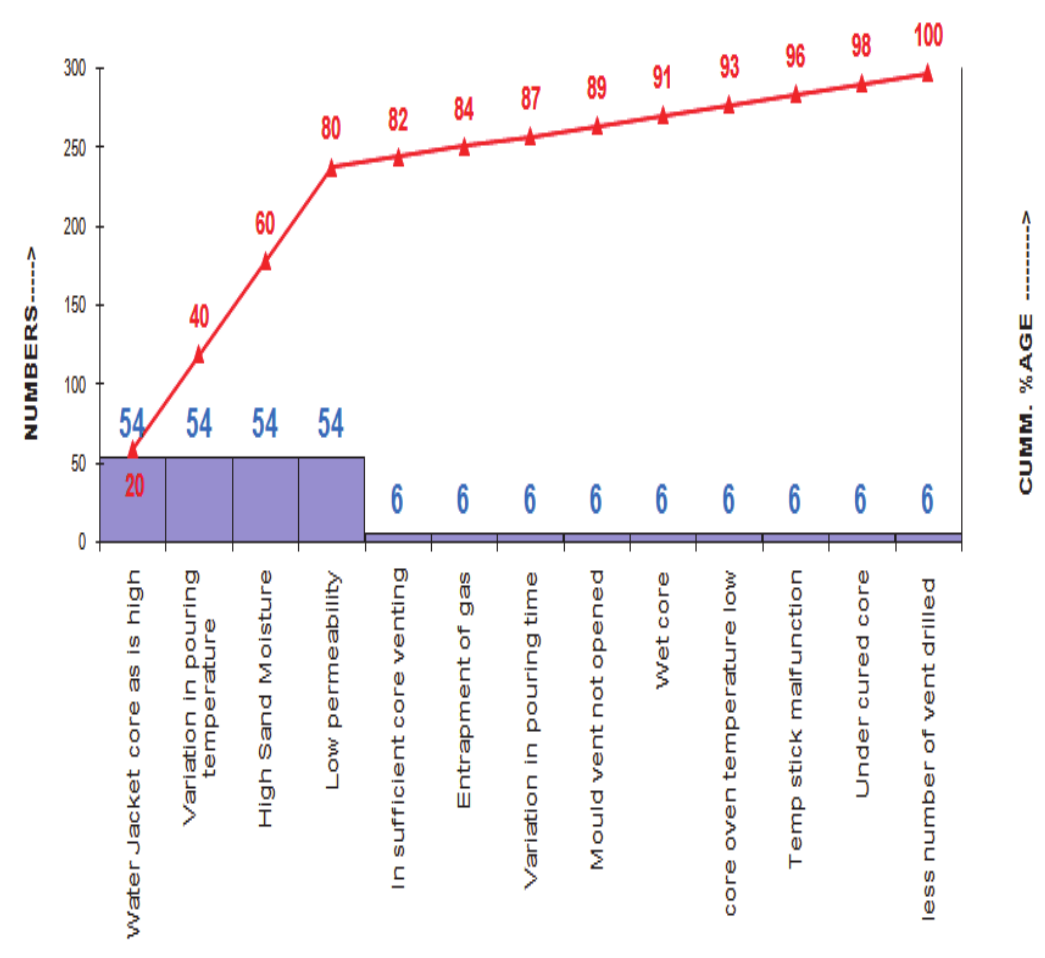
Fig. 6. Pareto on possible causes - Blowholes defect